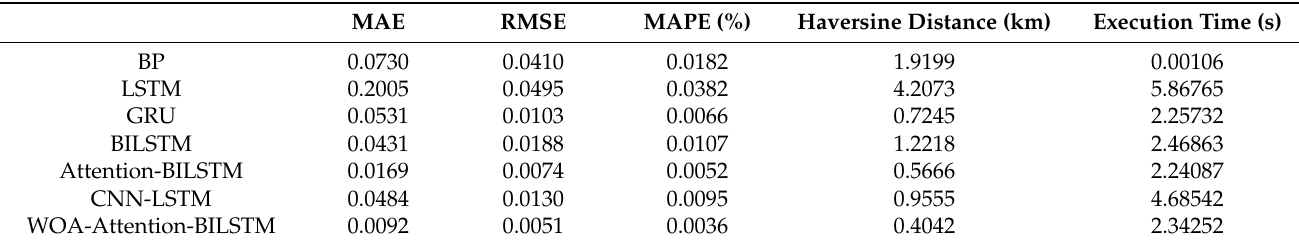
Table 5. Metrics of WOA-Attention-BILSTM and other models.